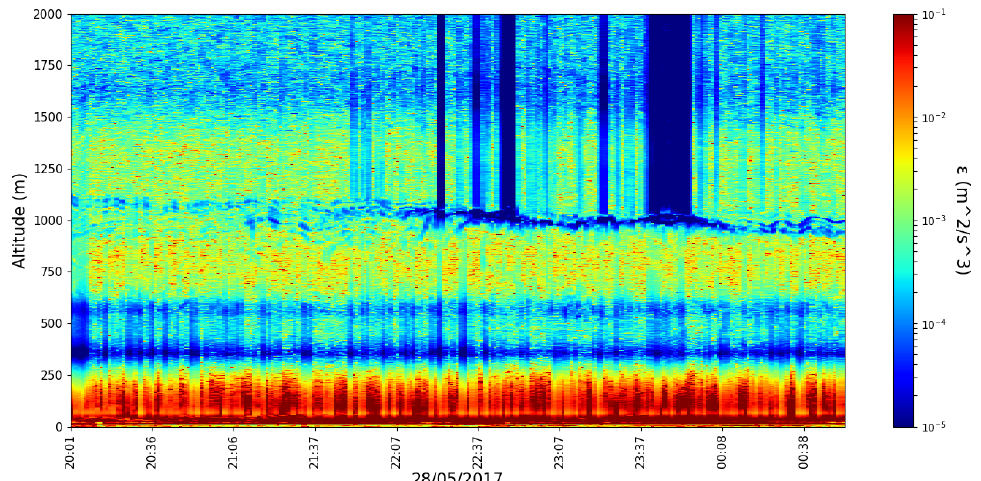
Atmosphere 2021 , 12 , x FOR PEER REVIEW Figure 14. 𝜀 profile timeseries, profiling rate 1/min, 28 April 2017. Figure 14. ε profile timeseries, profiling rate 1/min, 28 April 2017.